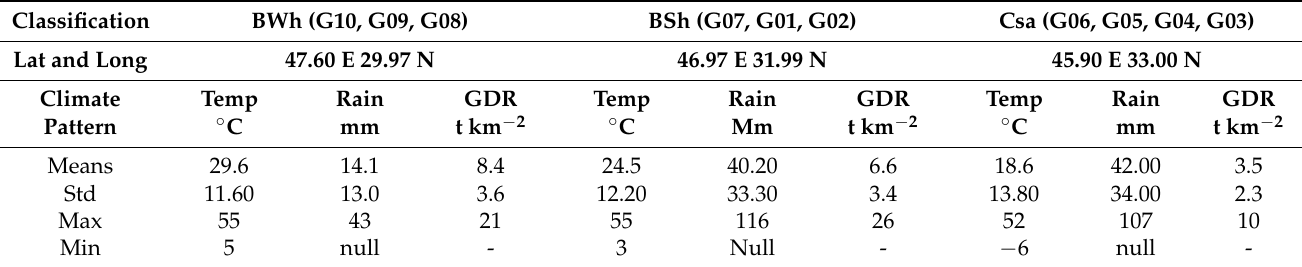
Table 5. Typical climate patterns relative to the deposition